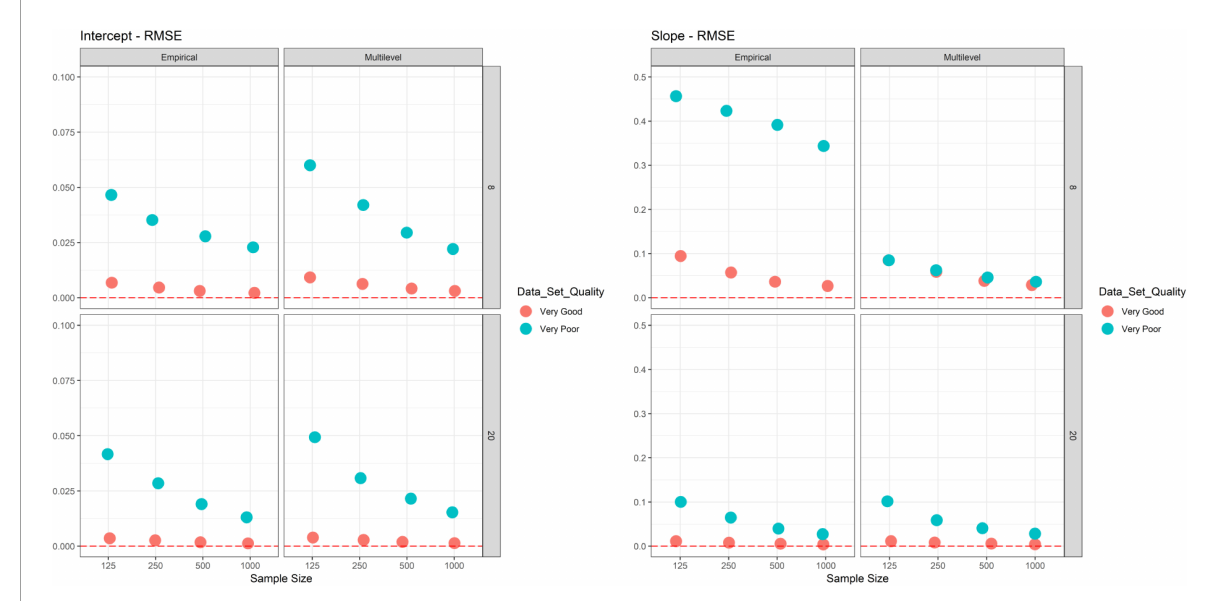
FIGURE4 Simulation study–RMSE results. Displayed is the RMSE for each cell of the design (1,000 replications).